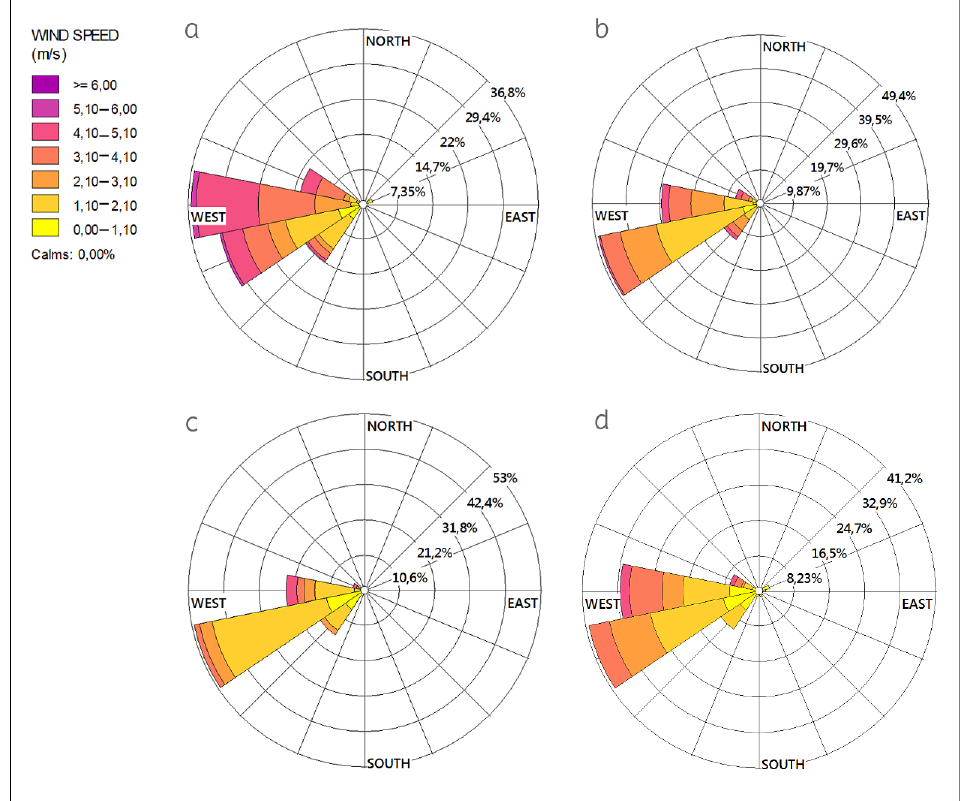
Figure 9. Wind roses by episodes:( a ) early morning, ( b ) morning, ( c ) afternoon and ( d ) night in March